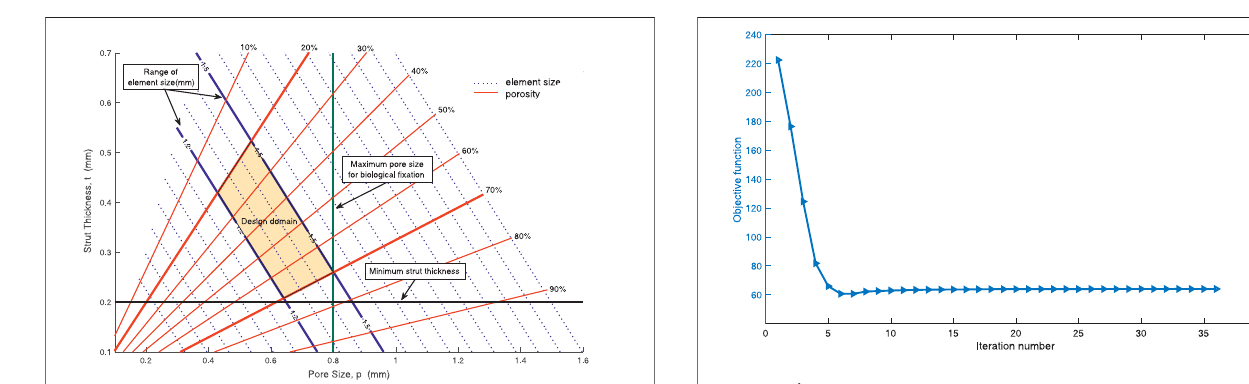
FIGURE 8 | Interplay between morphological parameters of an octet- truss cell and design constraints.